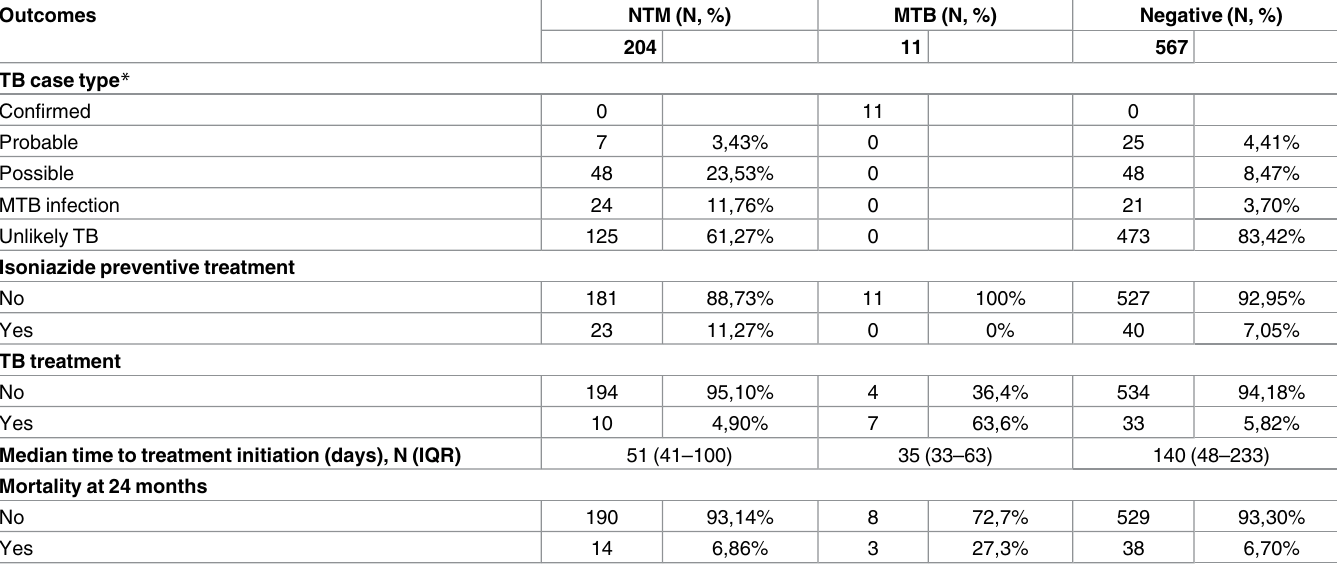
Table 4. Outcomes and follow-up information according to culture result at admission.